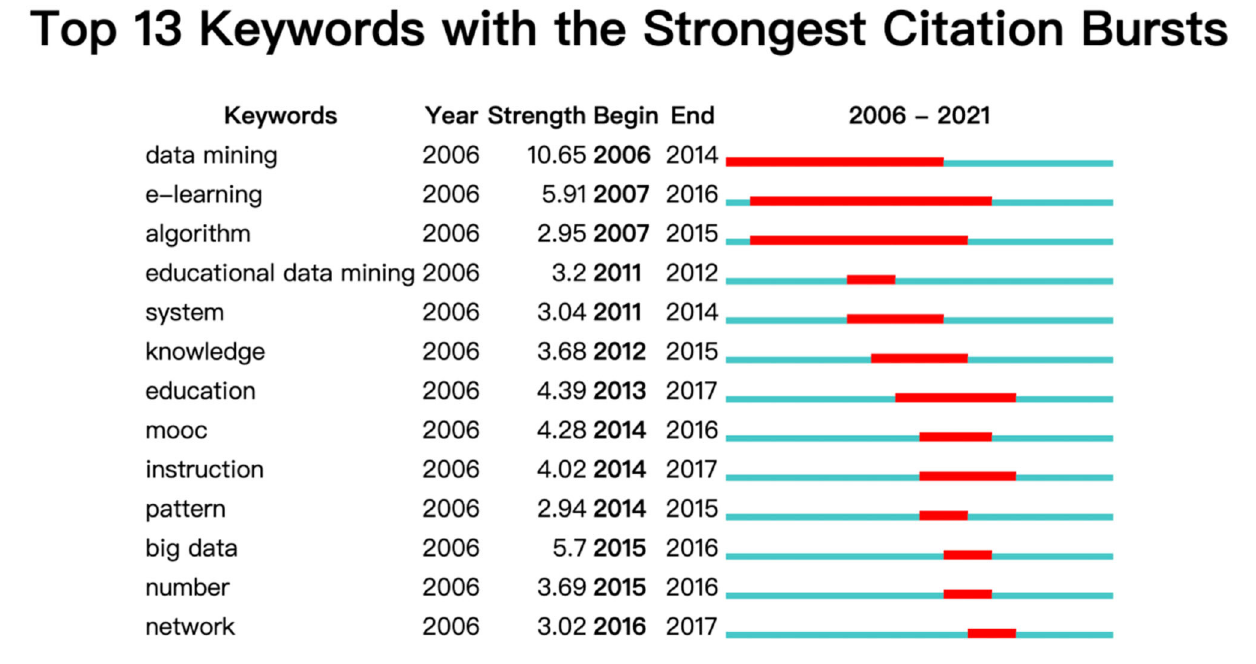
FIGURE 8 | Results of strongest citation bursts in educational big data.